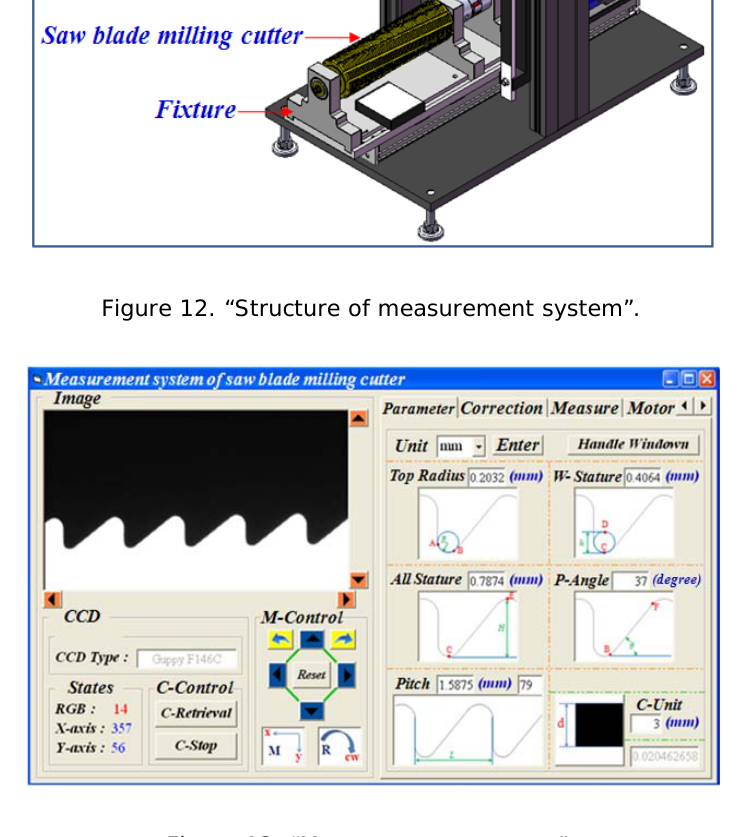
Figure 13. “Measurement